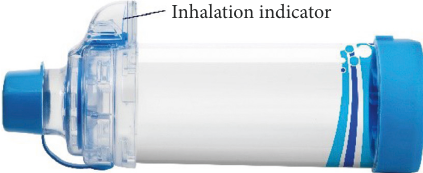
Figure 1: Valved holding chamber featuring an inhalation